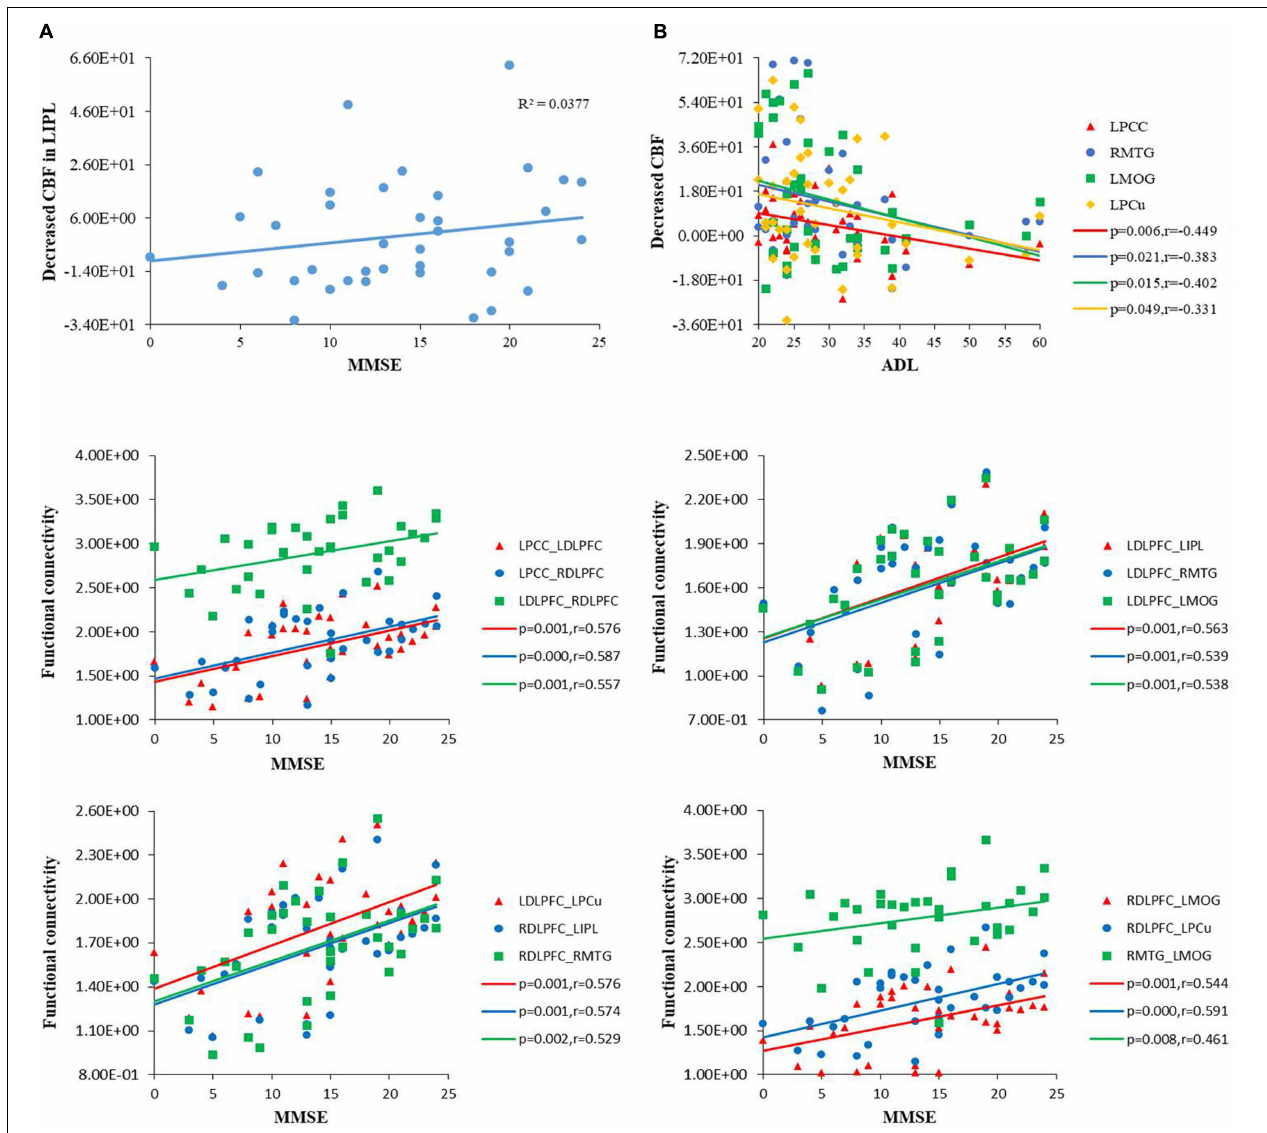
FIGURE 5 | (A) Scatterplot of uncorrected rCBF in the IPL plotted against MMSE score, and in the PCC, MTG, MOG, PCu against ADL score. MMSE, mini-mental state examination; ADL, activity of daily living scale. (B) Scatterplot of functional connectivities of the DMN, ECN and VN plotted against MMSE score ( P < 0.01). DMN, default mode network; ECN, executive control network; VN, visual